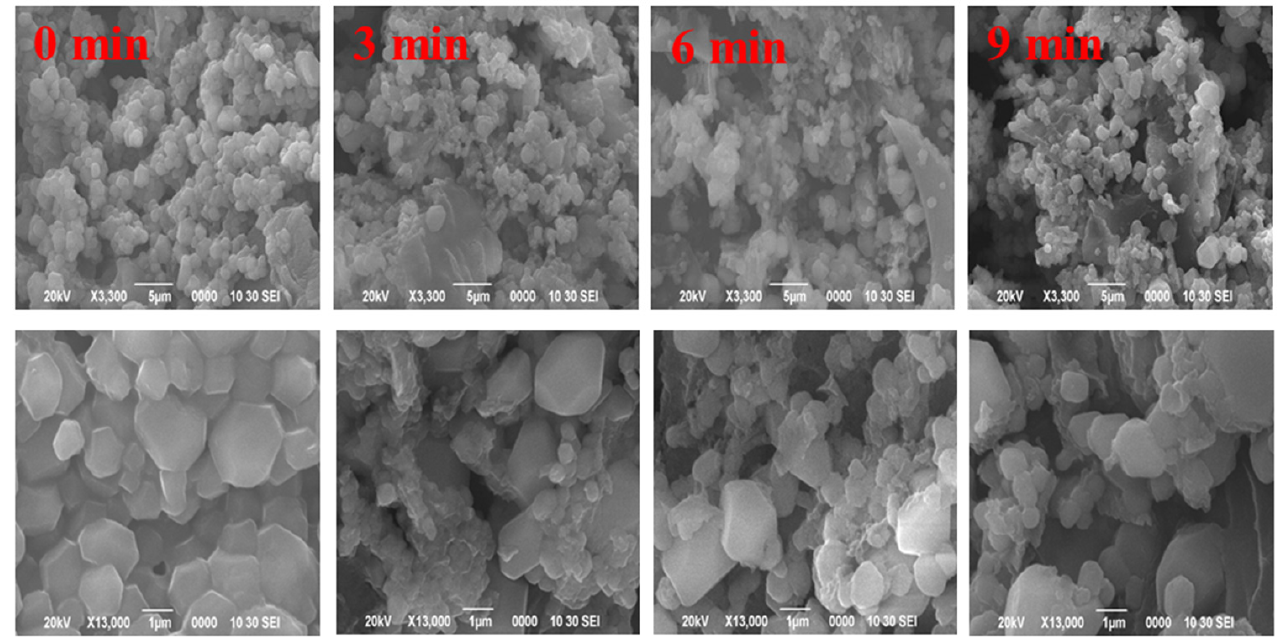
Figure 3. Microscopic images (SEM) of high-intensity ultrasound treated SC.